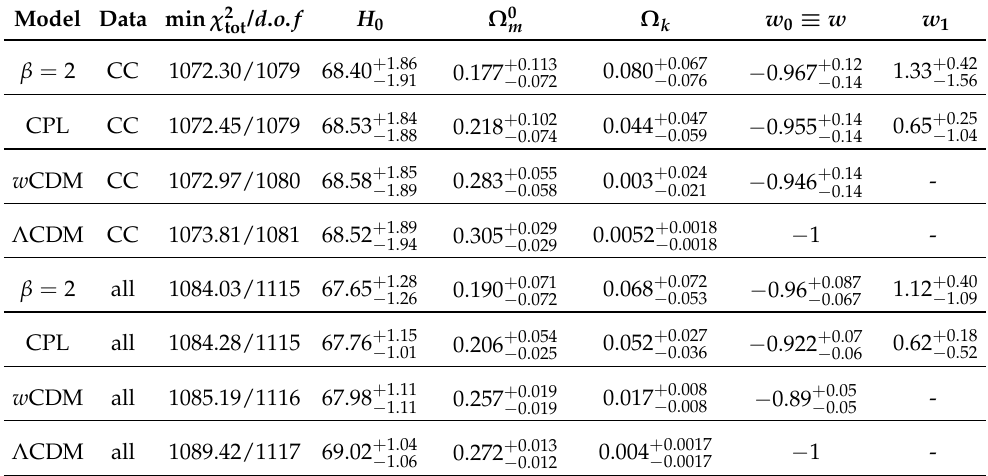
Table 2. The best fit values with 1 σ estimates of model parameters and min χ 2 and CC or all H ( z ) data for the models: β = 2 (32), CPL (23), w CDM, and Λ CDM. Model Data min χ 2 / d . o . f tot